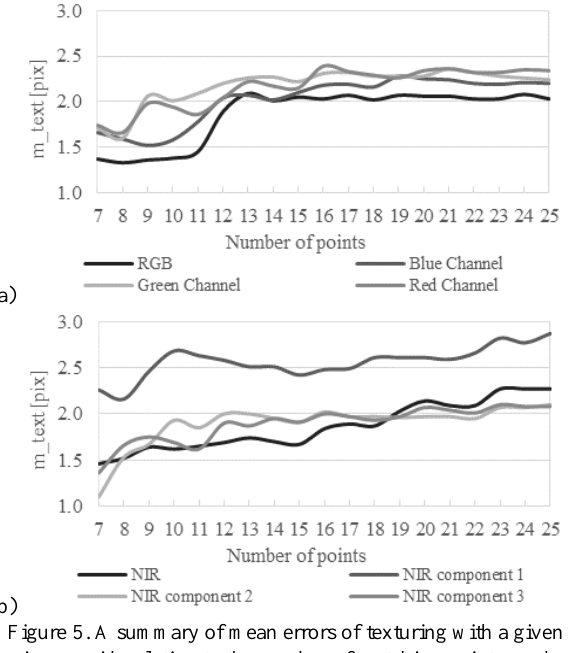
Figure 5. A summary of mean errors of texturing with a given image with relation to the number of matching points used